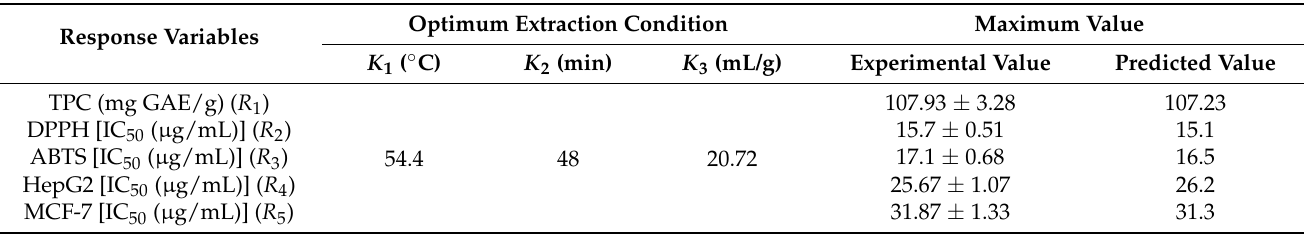
Table 6. Experimental and predicted values of the responses at the optimum extraction